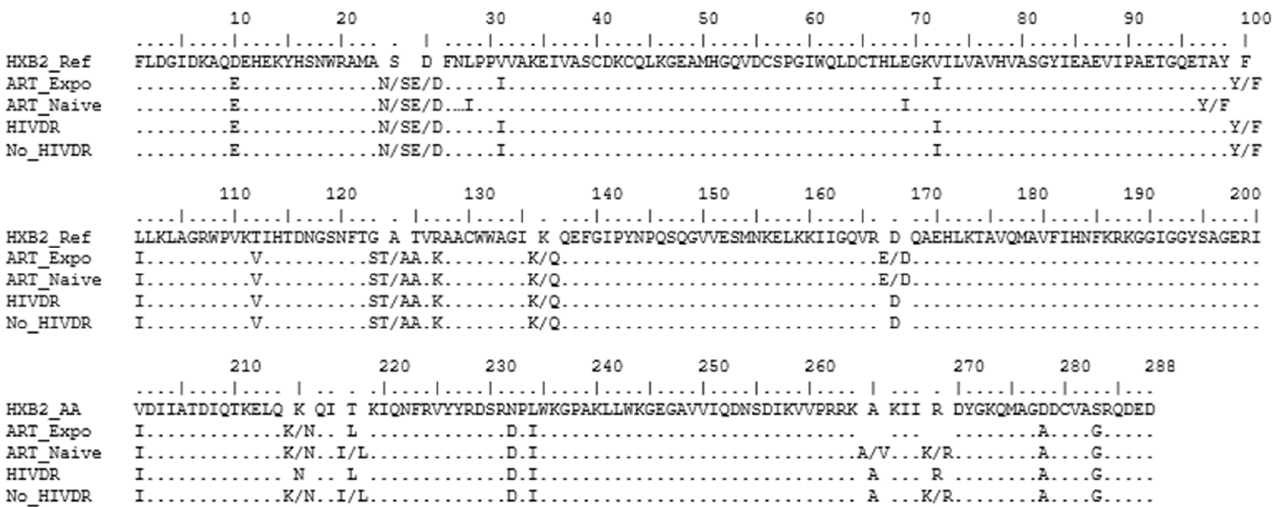
Figure 3. Alignment of Ethiopian HIV-1 subtype C integrase (IN) consensus sequence. The consensus sequence from the ART-naïve sequences ( n = 367) is represented as ART_Naive, and that from ART-experienced ( n = 87) is represented as ART_Expo. The consensus sequence from the sequence